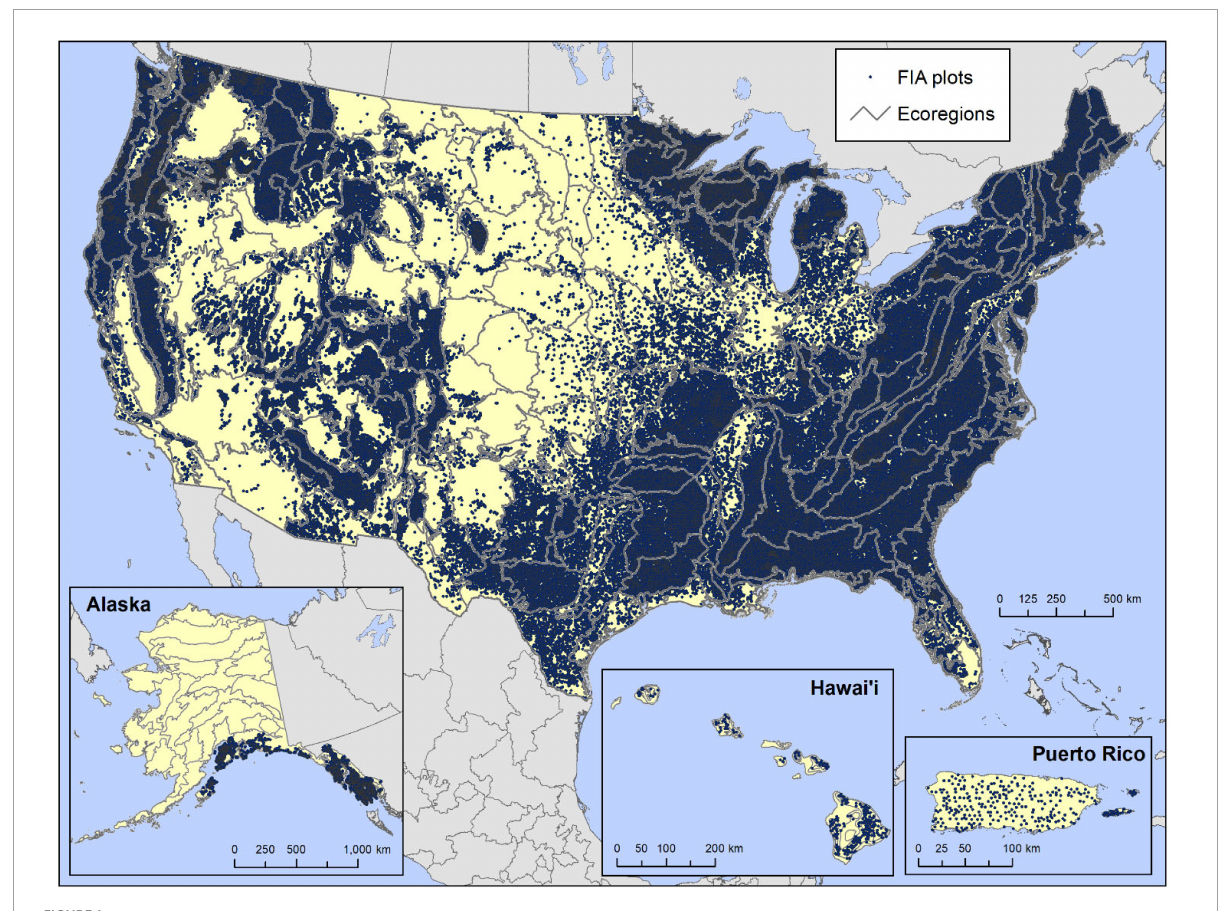
FIGURE1 Tree species occurrence data from 140,026 USDA Forest Service Forest Inventory and Analysis (FIA) plots in the conterminous United States and Alaska, 238 in Hawaii, and 294 in Puerto Rico.